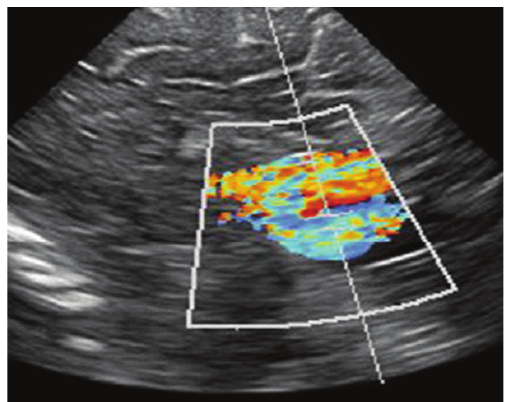
Figure 2: MRI (MPRAGE with contrasting agent): greatly expand- ed Vein of Galen